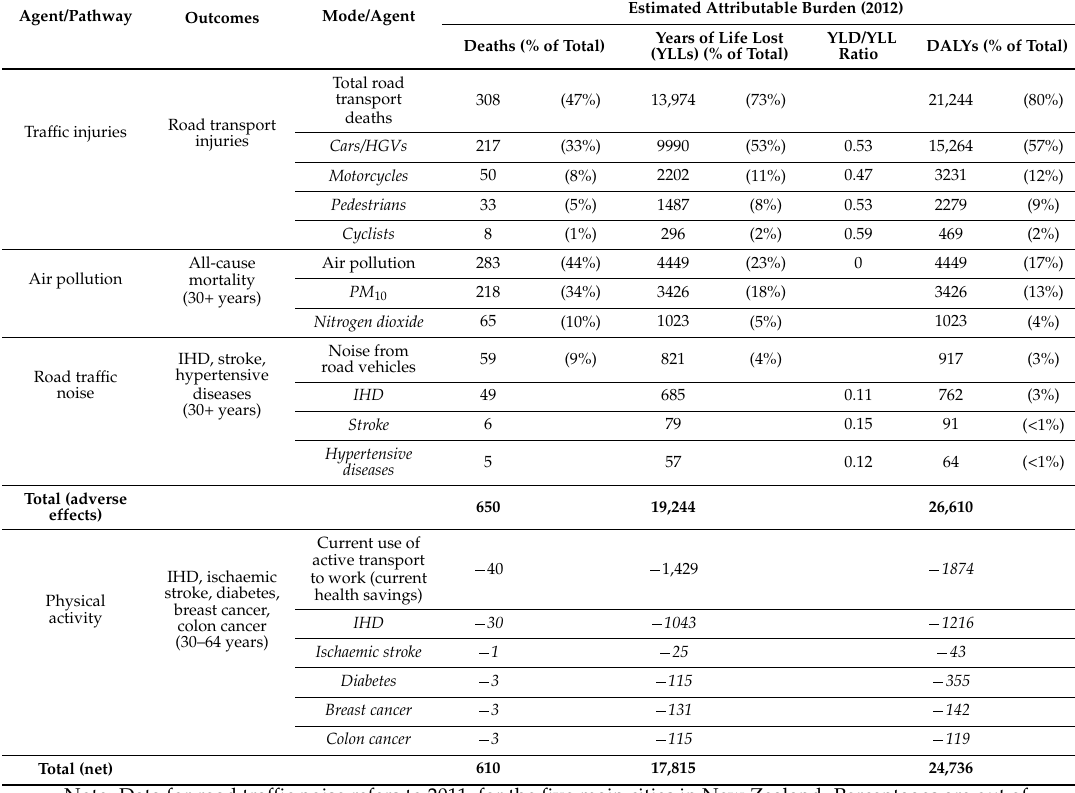
Table 2. Summary of estimated health impacts, 2012 (or latest